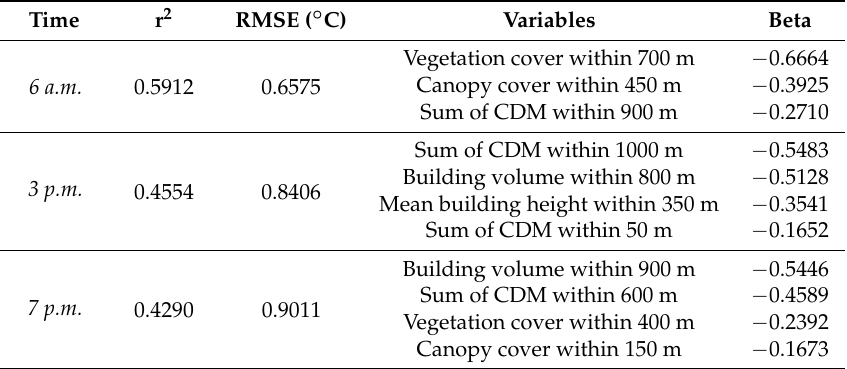
Table 2. MLR variables selected with stepwise linear regression. Standardized (Beta) coefficients provided for comparison of variable influence.